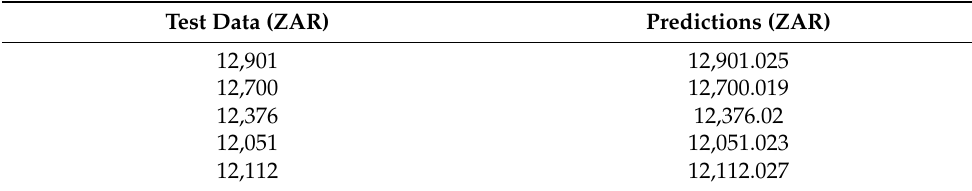
Table 6. Experiment 2.3